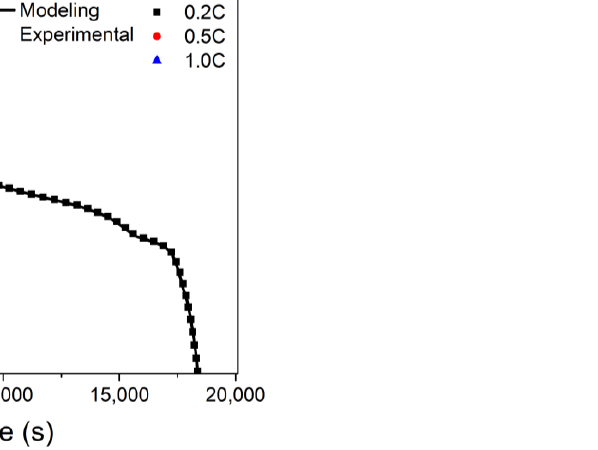
Figure 9. Comparison of modeling and experimental data of discharge behavior of LIB module at 0.2 C, 0.5 C, and 1 C.